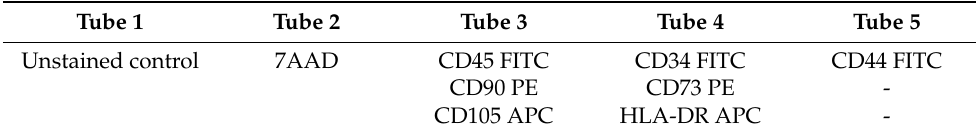
Table 2. The panel of used fluorescently labeled antibodies and dyes. Tube